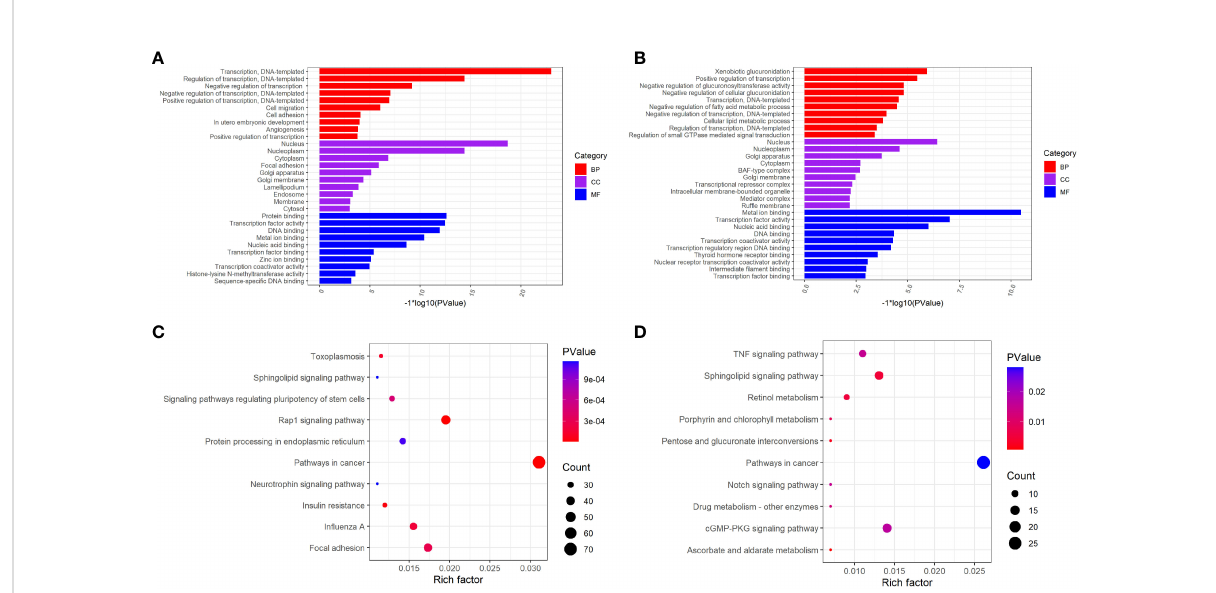
FIGURE 2 GO function and KEGG pathway enrichment of differently methylated m6A genes. (A) The top 10 GO terms of genes with down-regulated m6A peaks. (B) The top 10 GO terms of genes with up-regulated m6A peaks. (C) The top 10 KEGG pathways of genes with down-regulated m6A peaks. (D) The top 10 KEGG pathways of genes with up-regulated m6A